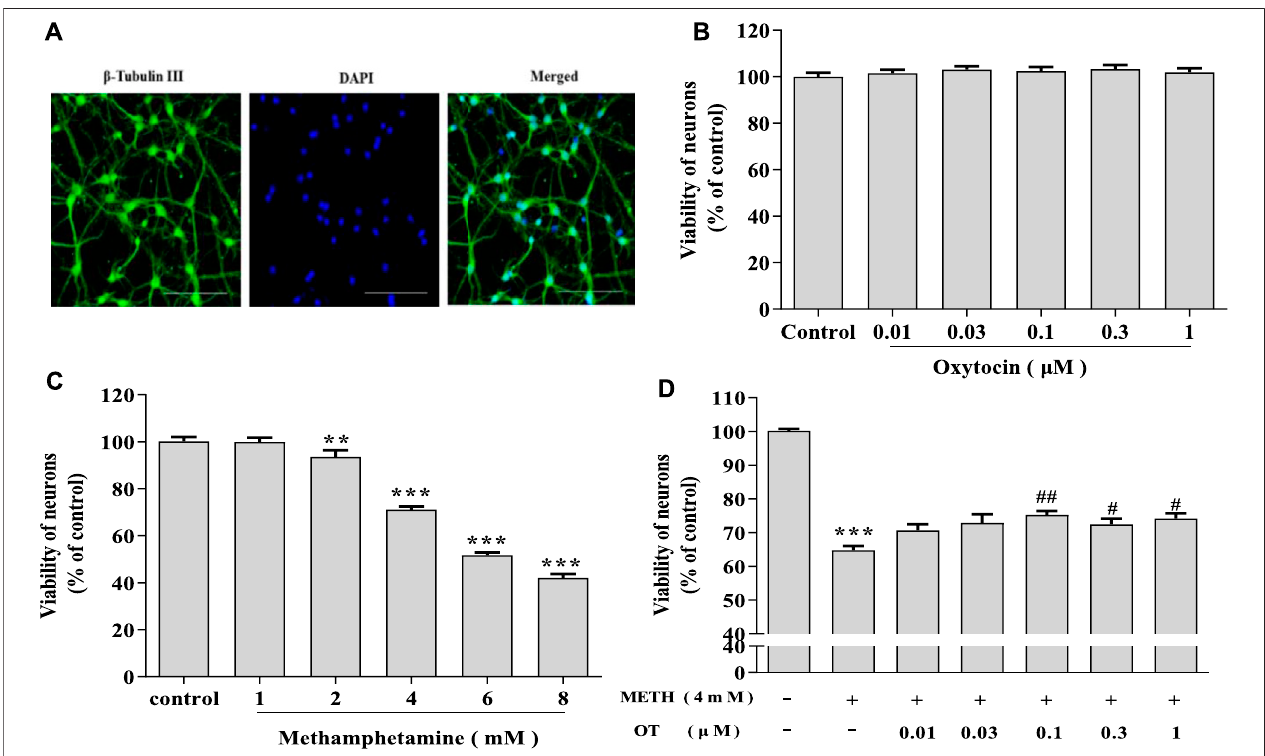
FIGURE 1 | OT attenuates the decrease in METH-induced hippocampal neuron survival. (A) Immunochemical identify of hippocampal neurons by fl uorescence dyeing. Neurons were stained with Cytoskeleton (green) ( × 20 objective, Scale bars (cid:2) 50 μ m). Nuclei were counter stained with DAPI (blue). (B) Hippocampal neurons were treated with OT (0.01 – 1 μ M) for 24 h (C) Hippocampal neurons were treated with METH (1 – 8 mM) for 24 h. (D) Hippocampal neurons were pre-treated with OT (0.01 – 1 μ M) for 2 h and stimulated with METH (4 mM) for 24 h before detected. All the values were shown as mean ± SEM ( n (cid:2) 3). ** p < 0.01, *** p < 0.001 versus control groups; # p < 0.05, ## p < 0.01 versus METH